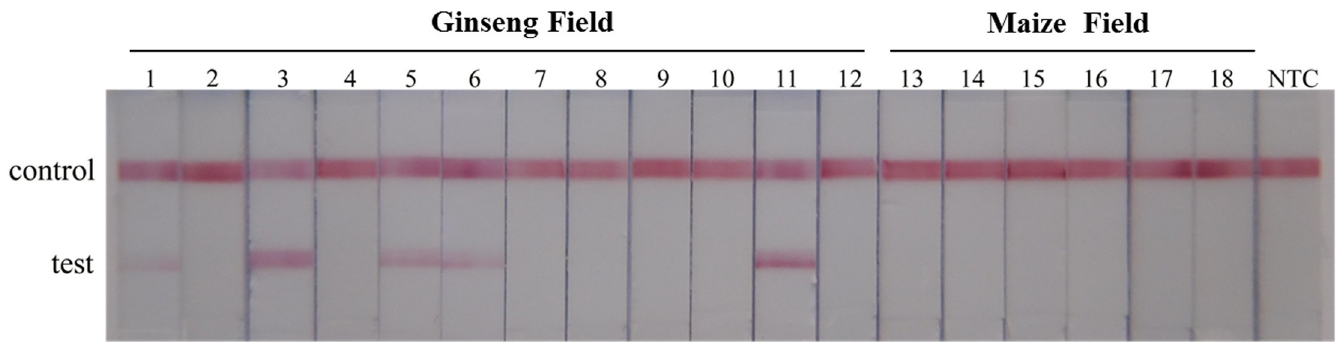
Fig 6. Performance of the STNPCR-LFBA on real samples. Biosensor 1–12: STNPCR-LFBA results for 12 soil samples cultivated ginseng, biosensor 13–18, STNPCR-LFBA results for 6 soil samples cultivated maize. NTC: no template control.